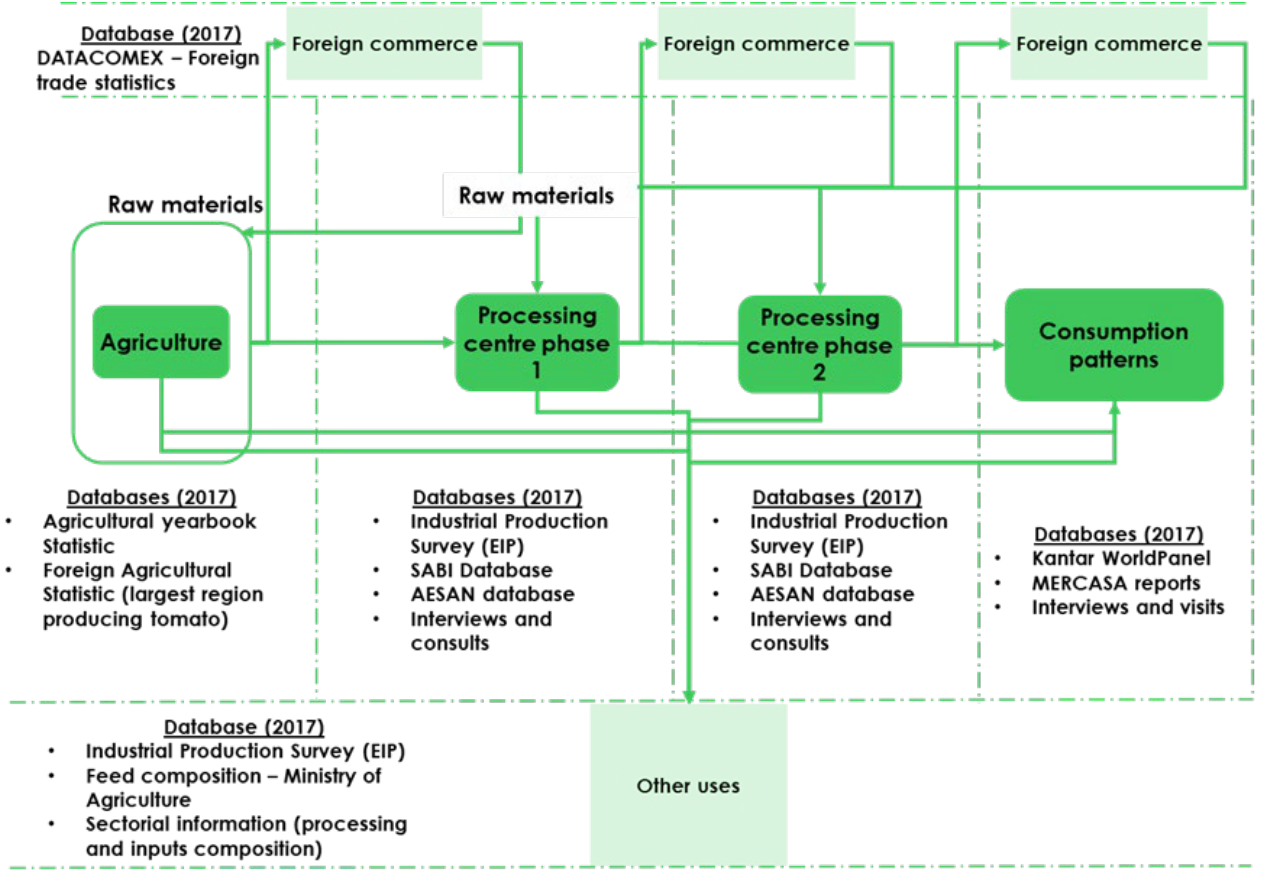
Figure 2. Diagram of the databases and paths to the point of sale. DATACOMEX: Foreign trade statistics of goods from Spain and the EU, SABI: Spanish acronym for Iberian Balance Sheet Analysis System, it provides information about Spanish companies or groups of companies, AESAN: Spanish acronym for Spanish Agency for Food Safety and Nutrition, MERCASA: a public company of the State Administration that has been providing a public service to the entire food chain since 1966, structuring the largest network of wholesale markets in the world, which covers the whole of Spain’s territory. (See Supplementary Material supported by references [25–53]).